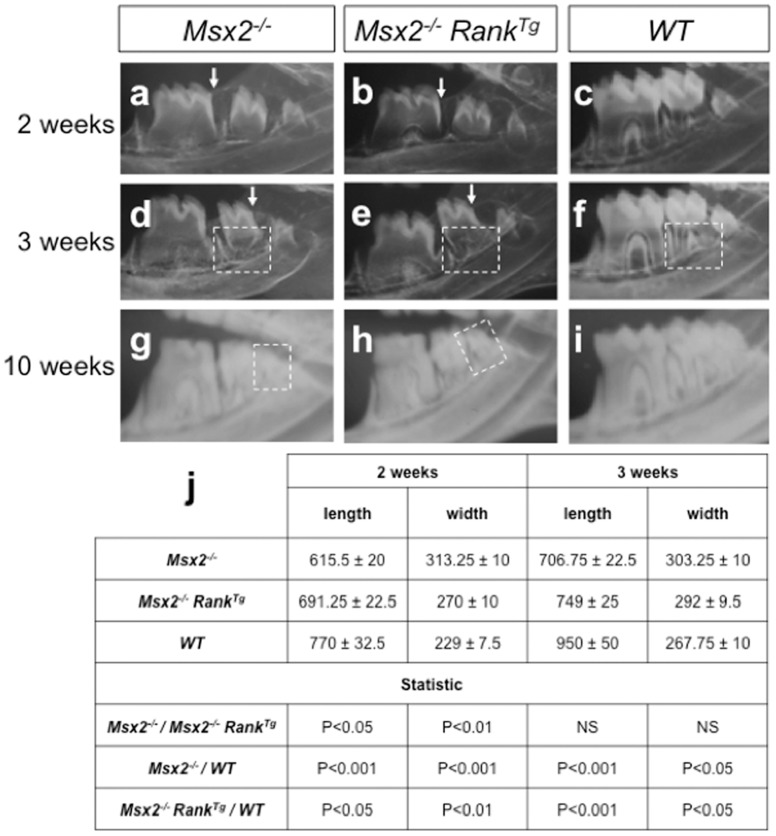
Effect of transgenic Rank on lower molar growth in Msx2
−
/− mice.Microradiographs were taken at 2 (a–c), 3 (d–f), and 10 (g–i) weeks for Msx2
−/− mice overexpressing (b, e, and h) or not expressing (a, d, and g) transgenic Rank, and for WT mice (c, f, and i). At 2 and 3 weeks, eruption of the first and second molars was more advanced in Msx2
−/−
RankTg mice than in Msx2
−/− mice, as shown by their positions relative to the vestibular bone crest (arrows in a, b, d, and e). At 3 weeks, the most significant feature of the progression in second molar growth was the more advanced root elongation in Msx2
−/−
RankTg mice compared to Msx2
−/− mice (squares in e versus d). However, the root lengths did not match those of WT mice (square in f). At 10 weeks, while the third molars of Msx2
−/− mice were completely surrounded by and indistinguishable from bone on the microradiograph (square in g), the third molars of Msx2
−/−
RankTg mice were fully erupted and functional (square in h). Measures of the first molar mesial root length and width at the median position (in µm) were performed on histological sections and presented in a table form (j). A higher length and lower width were observed at 2 weeks for Msx2
−/−
RankTg molar root comparatively to Msx2
−/− molar root. However, Msx2
−/−
RankTg molar root length and width remained respectively lower and superior to those observed for WT molar root. At 3 weeks, no significant difference of length and width was observed between Msx2
−/−
RankTg and Msx2
−/− molar roots.